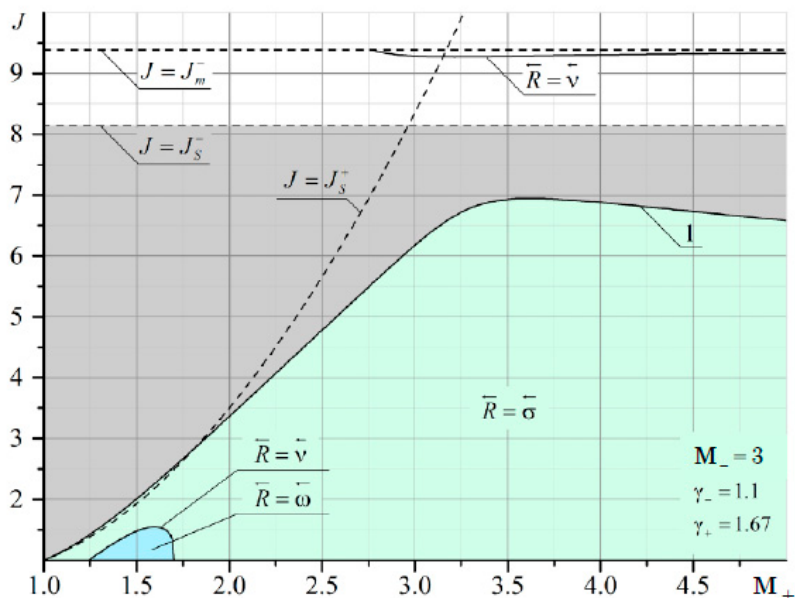
Figure A5. Domains of existence of reflected discontinuities for refraction from a gas consisting of combustion products into a monatomic gas. The Mach number of the flow from which the shock comes is M – = 3.